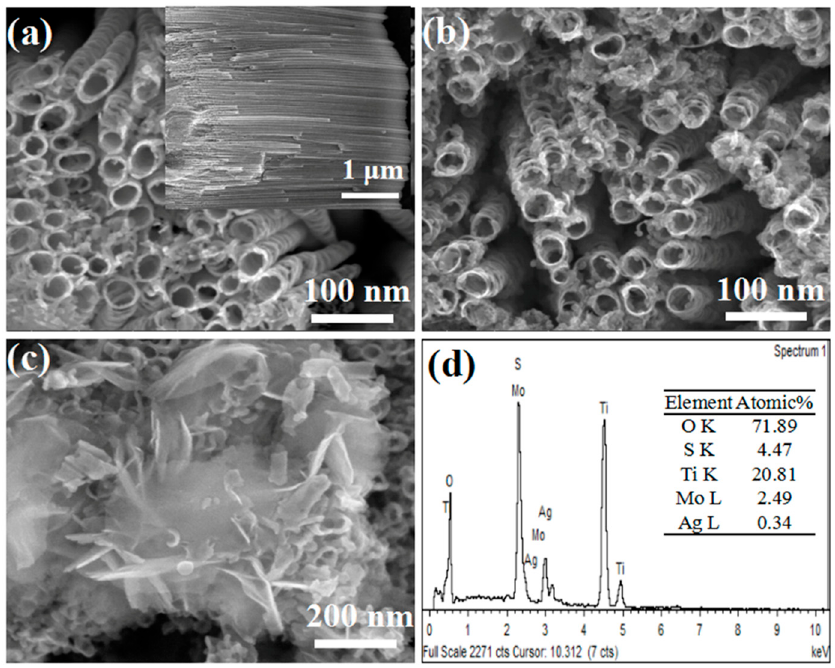
Figure 2. SEM images of ( a ) TiO 2 NTs; ( b ) TiO 2 NTs/Ag; and ( c ) TiO 2 NTs/Ag/MoS 2 ; ( d ) EDS analysis of TiO 2 NTs/Ag/MoS 2 .